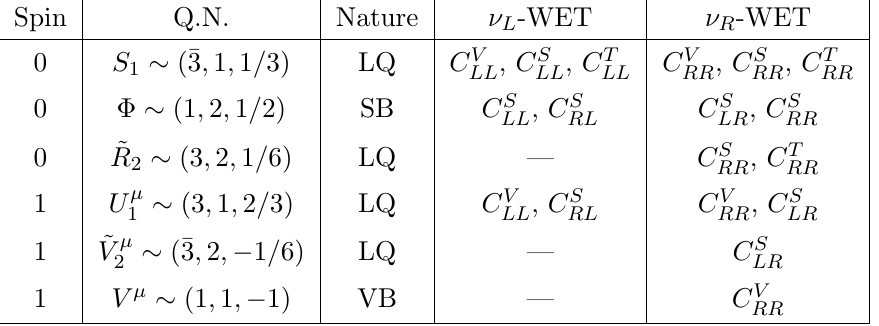
Table 1 . Spin, SU(3) C (cid:10) SU(2) L (cid:10) U(1) Y quantum numbers and nature (LQ = leptoquark, SB = scalar boson, VB = vector boson) of the possible candidates to mediate b ! c transitions involving (cid:23) R (cid:24) (1 ; 1 ; 0). The fourth and (cid:12)fth columns list the operators with left-handed and right-handed neutrinos, respectively, generated by the integration of the correspondent mediator.